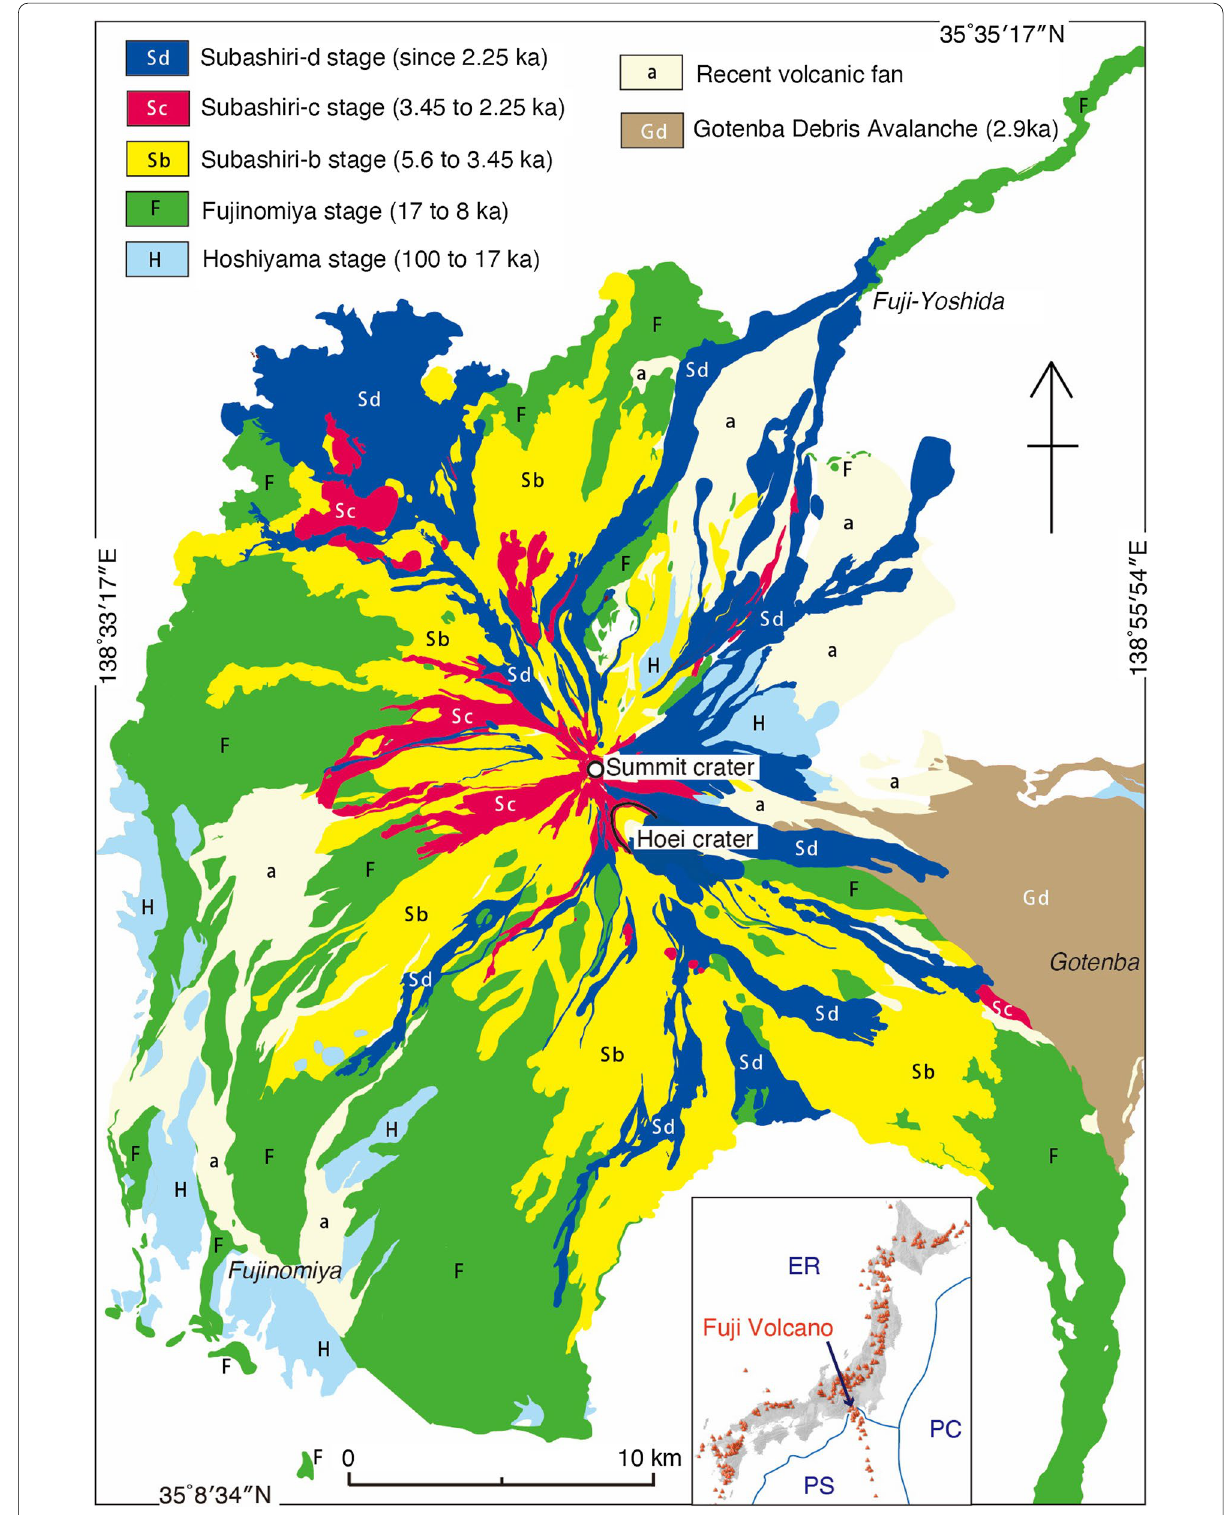
Fig. 1 Simplified geologic map of Fuji Volcano. There is no mappable unit for the Subashiri-a stage (8 to 5.6 ka), because this was a quiescent period without lava flows. Modified from Takada et al. (2016). Red triangles in the index map are Quaternary volcanoes; ER plate, PS Philippine Sea =